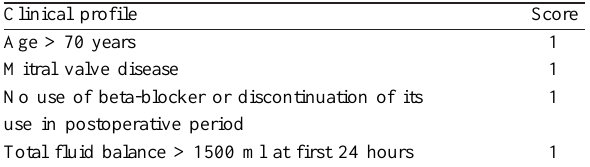
Table 2. Factors associated with development of atrial fibrillation after cardiac surgery and appropriate score Clinical profile